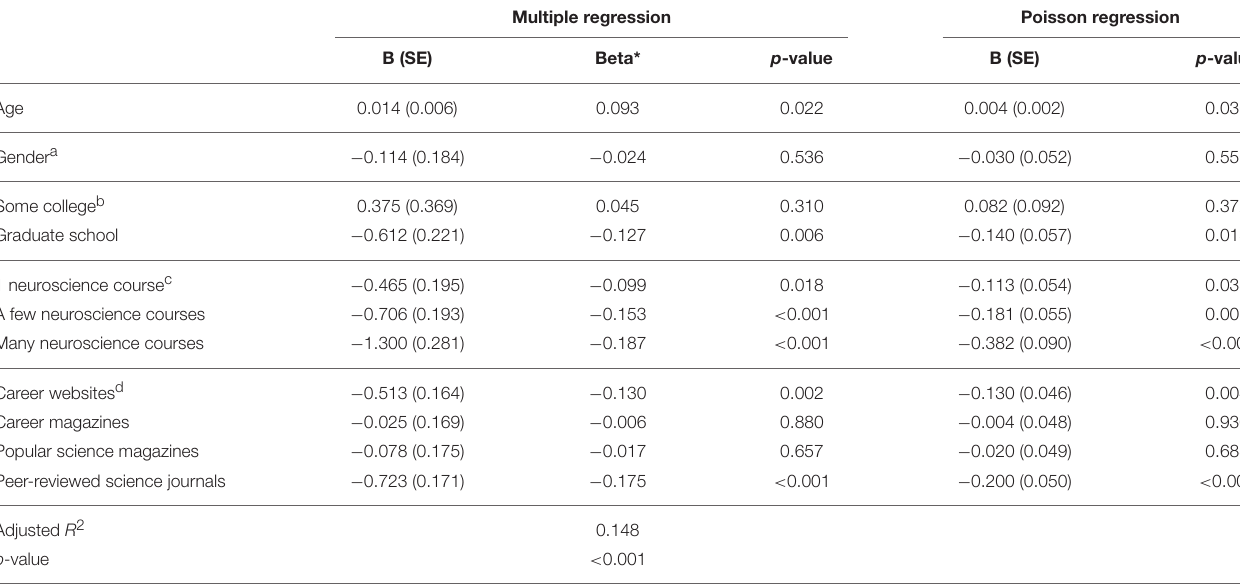
TABLE 8 | Regression results predicting neuromyths (i.e., % of items incorrect from neuromyths factor) in the educator sample ( N =